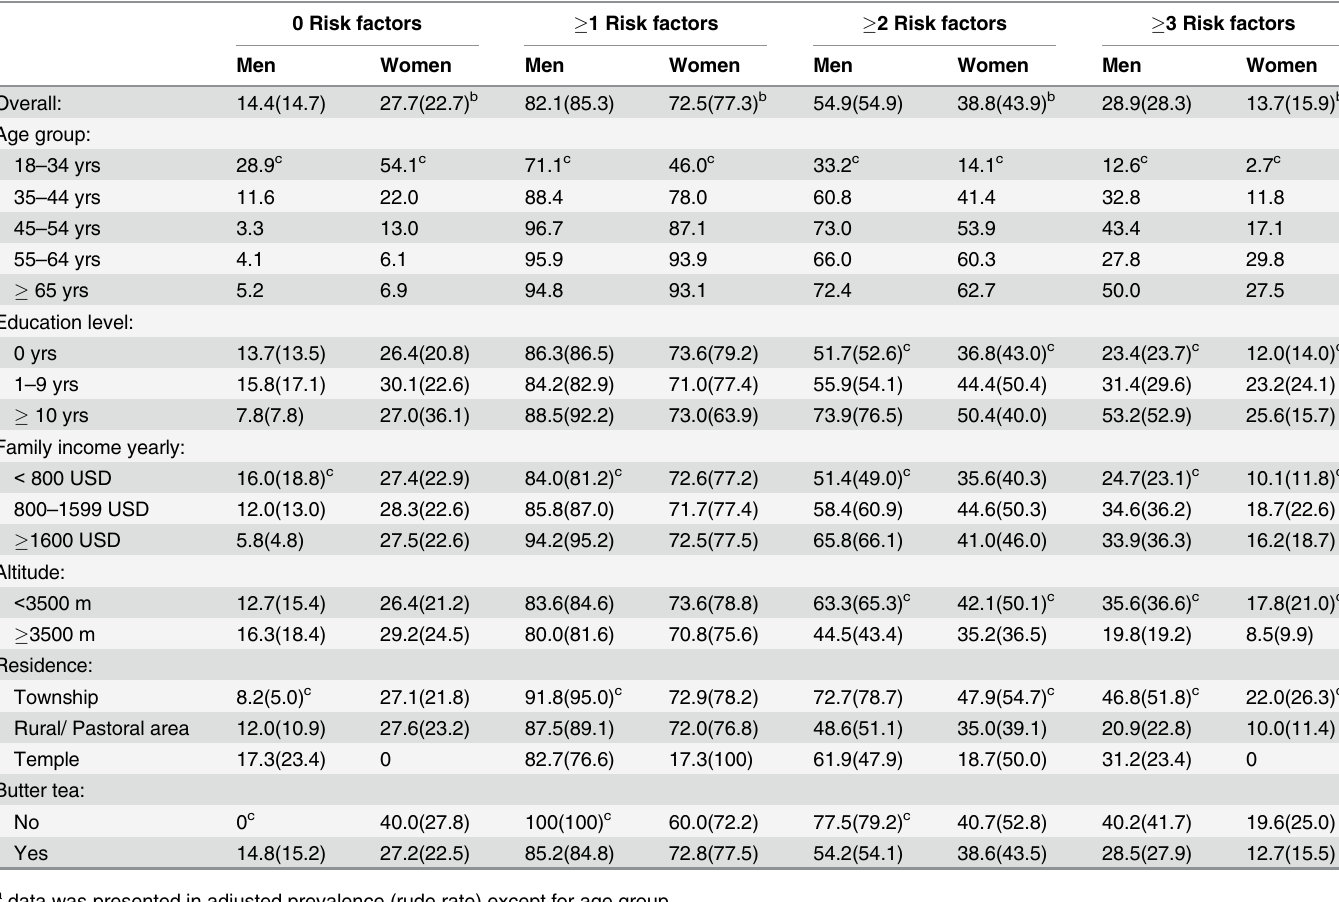
Table 5. The age-adjust prevalence with different numbers of CVD risk factors among Tibetan men and women. a